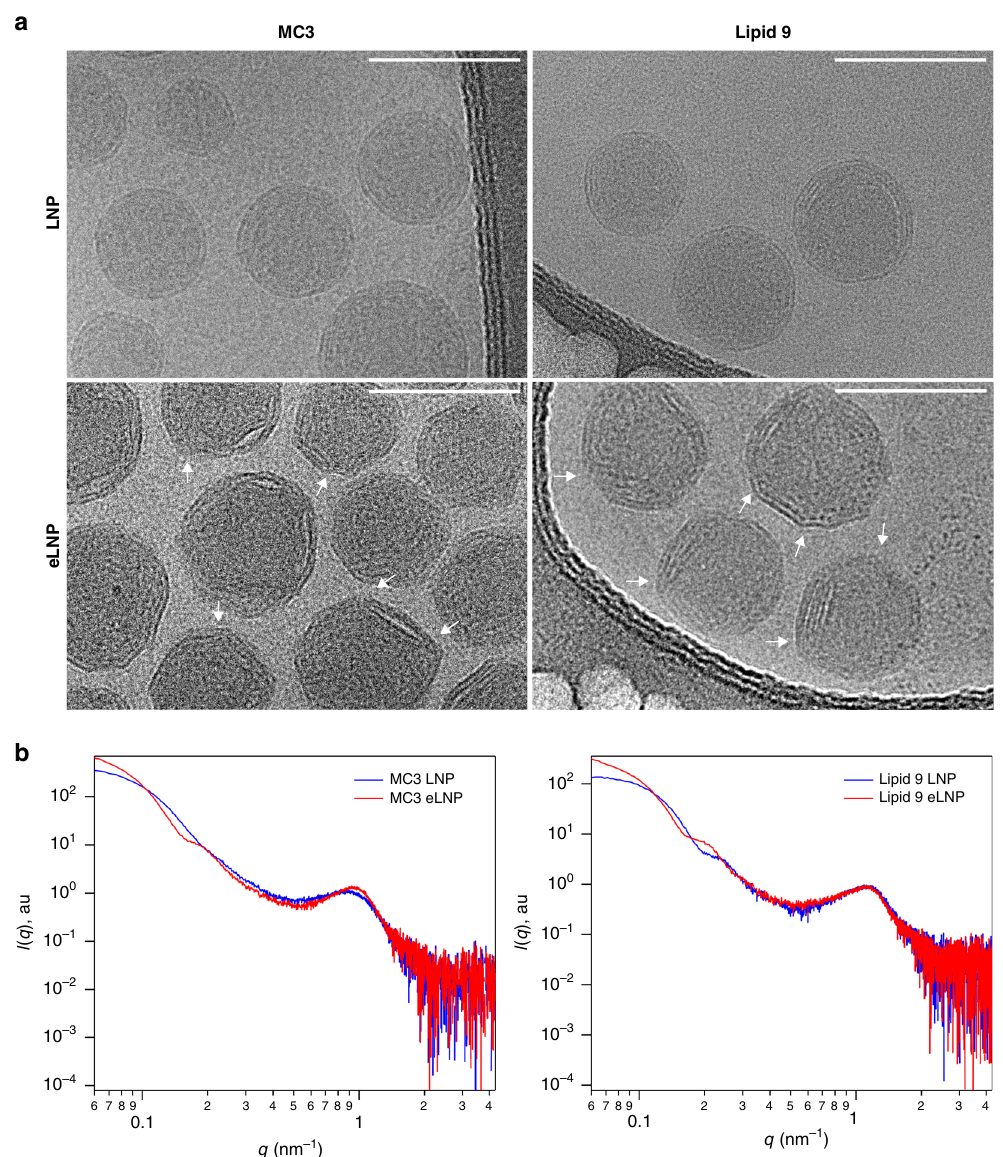
Fig. 3 Impact of β -sitosterol on nanoparticle structure and morphology. a Cryo-TEM showing structural difference between LNP and eLNP (white arrows showing edges not observed in the spherical LNPs). Scale = 100 nm. b Small-angle X-ray scattering pro fi les of LNPs and eLNPs containing MC3 or Lipid